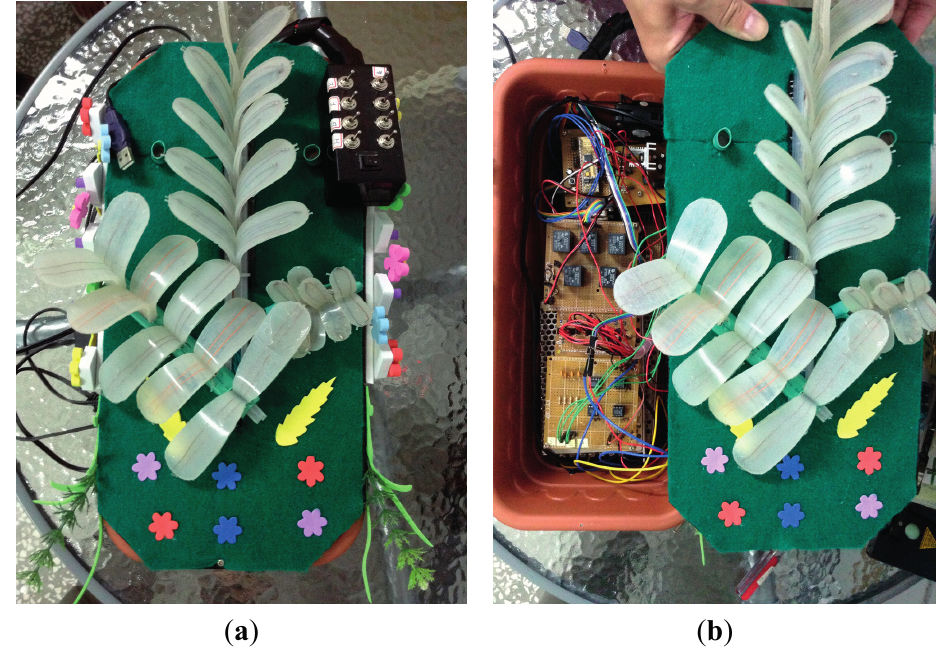
Figure 2. Mimosa system appearance: ( a ) mimosa robot shape and ( b ) internal circuit board configuration.